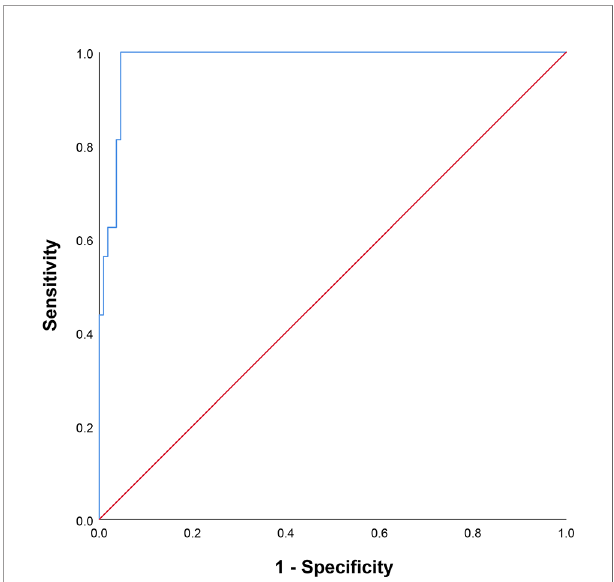
FIGURE 4 | Receiver operating characteristic curve of maximum dose applied to the neuro-optic